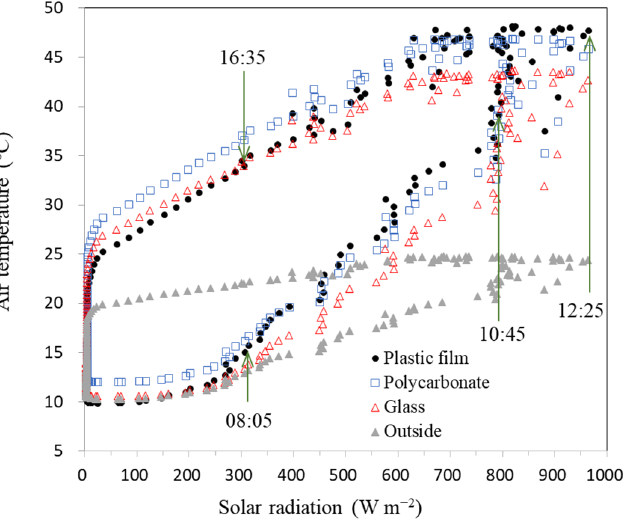
Figure 5. Comparison of indoor and outdoor air temperatures as a function of solar radiation in greenhouses covered with different covering materials (12 − 13, 19 − 20, and 26 − 27 October